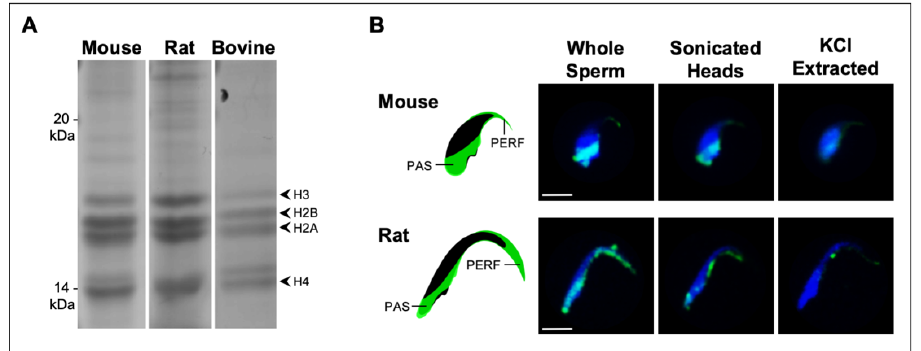
Figure 5. Comparison of KCl extracts between murid and bovine sperm and localization of core histones in murid PT before and after KCl treatment: ( A ) Coomassie-stained PAGE gel displaying KCl protein extracts from mouse, rat, and bovine whole sperm. Sperm were sonicated and washed before KCl extraction to remove acrosomal contaminants. The banding patterns of the four core histone sub-units were consistent across all three species, indicating that the KCl extraction method is effective in various sperm head morphologies. ( B ) Immunofluorescent labeling of mouse and rat sperm (Whole Sperm), with an anti-pan histone antibody localizing core histones (green) to the PAS and PERF regions of the PT. The diagrammatic mouse and rat sperm heads demonstrate the labeling of the anti-pan histone antibody in the PAS and PERF regions (green). Labeling was drastically decreased in sperm from both murid species following mild sonication in 1 M KCl (KCl extracted), with a vestige of core histone content persisting in the PERF region. Sonication (sonicated heads) did not appear to significantly reduce labeling of PT core histones relative to untreated whole sperm. DAPI labeled the nucleus (blue). Refer to Figure S1 for more detail regarding immunolocalization of histones in mouse sperm. Bar = 5 μ M. Table 1. Comparison of mass spectrometry analyses of PT histones between species.